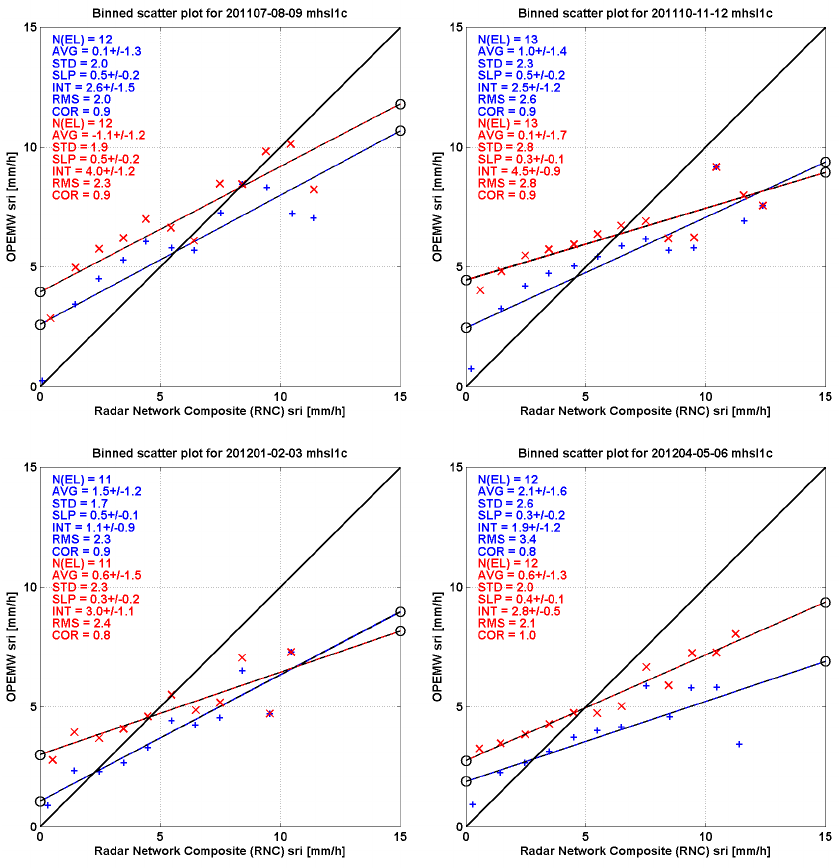
Figure 9: Scatter plot of seasonal binned analysis as in Fig. 8, but with respect to RNC. Clockwise from top-left panel: Summer, Fall, Winter, and Spring. Markers and statistics are as in Fig. 7. Error bars have been omitted for improving figure readability.